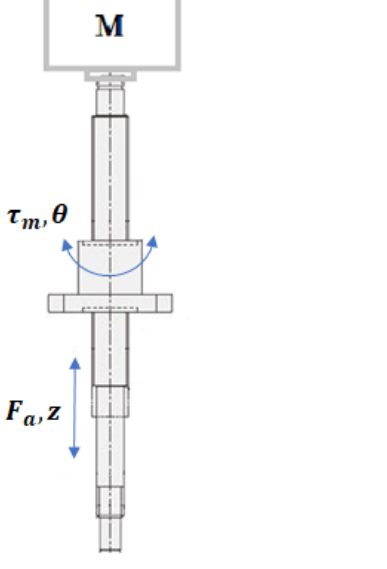
Figure 2. Subsystem assembly